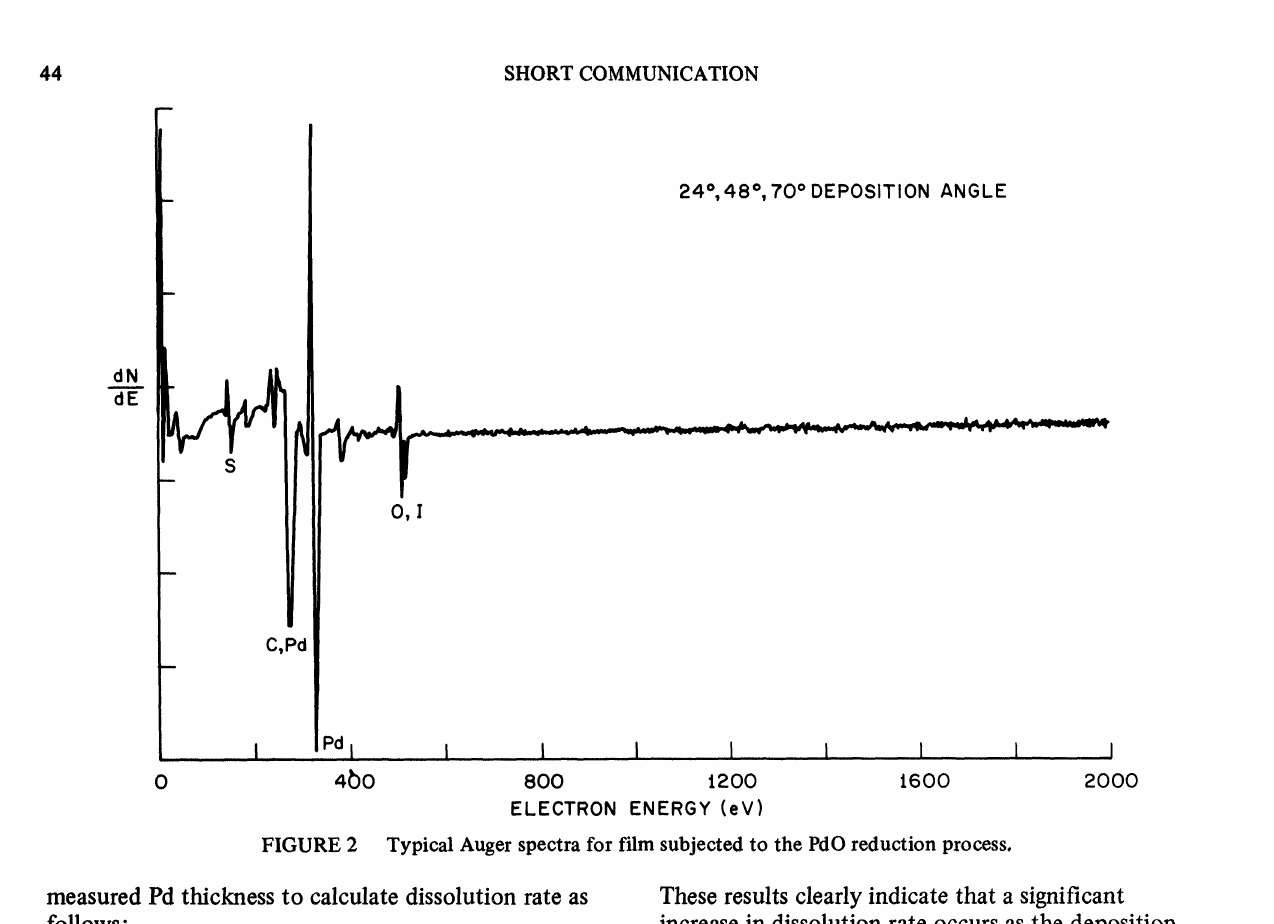
, 24", 48 70 DEPOSITION ANGLE